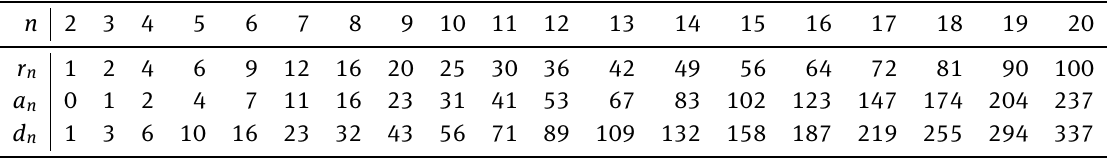
Table 9: Right, acute, and all 0/1 -triangles in I n modulo the action of B n .